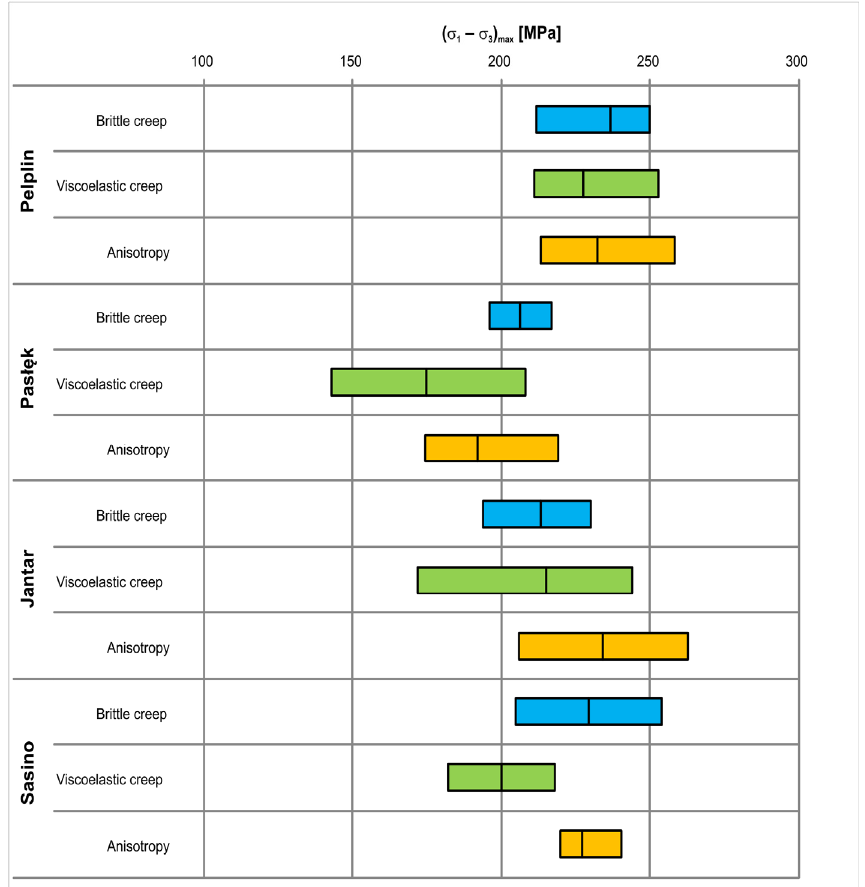
Figure 17. Comparison of strength ranges from brittle and viscoelastic creep tests, and mechanical anisotropy experiments in particular lithostratigraphic units.